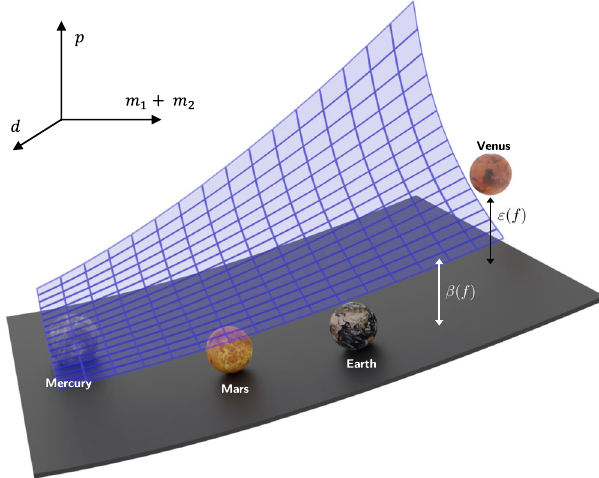
Fig. 1 | Visualization of relevant sets and their distances. The numerical data, background theory, and a discovered model are depicted for Kepler ’ s third law of planetary motion giving the orbitalperiod ofa planetinthe solar system.The data consistsofmeasurements( m 1 , m 2 , d , p )ofthemassofthesun m 1 ,theorbitalperiod p and mass m 2 for each planet and its distance d from the sun. The background theoryamountstoNewton ’ slawsofmotion,i.e.,theformulaeforcentrifugalforce, gravitational force, and equilibrium conditions. The 4-tuples ( m 1 , m 2 , d , p ) are projectedinto( m 1 + m 2 , d , p ).Thebluemanifoldrepresentssolutionsof f B ,whichis the function derivable from the background-theory axioms that represents the variable of interest. The gray manifold represents solutions of the discovered model f . The double arrows indicate the distances β ( f ) and ε ( f